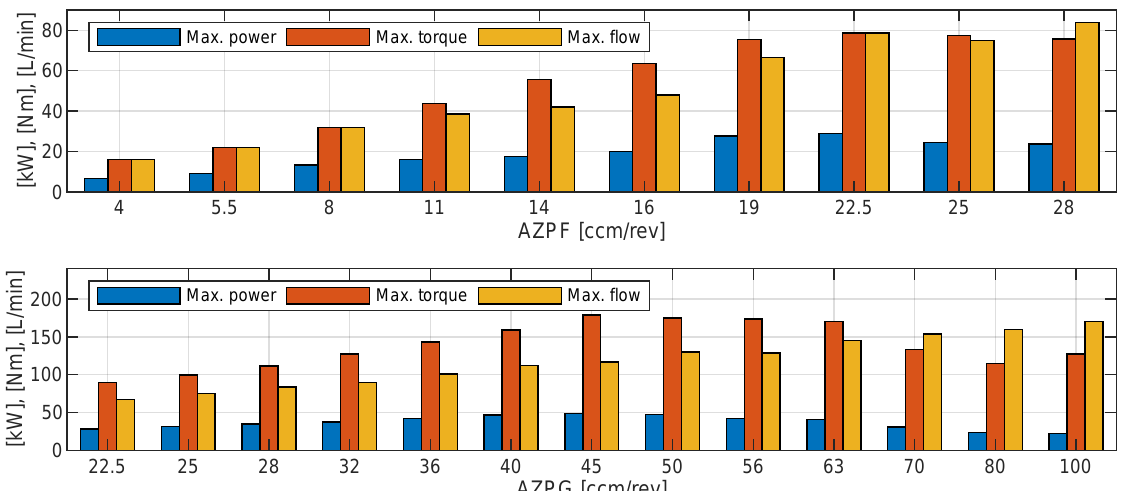
Figure 13. Flow, torque, and power ranges for standard external gear pumps (Bosch Rexroth AZPF and AZPG), assuming ideal